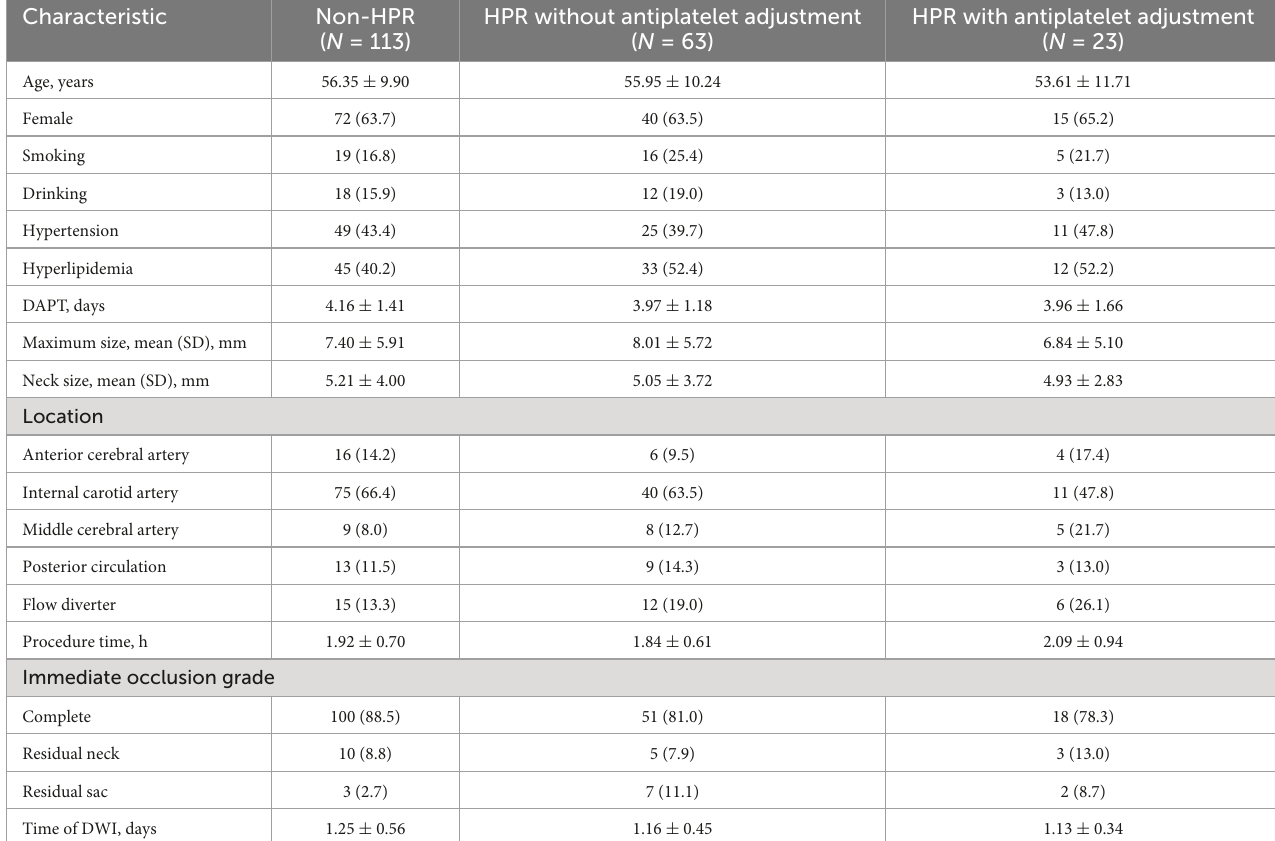
TABLE 1 Baseline characteristics of ACSI patients with non-HPR, HPR without antiplatelet adjustment, and HPR with antiplatelet adjustment.